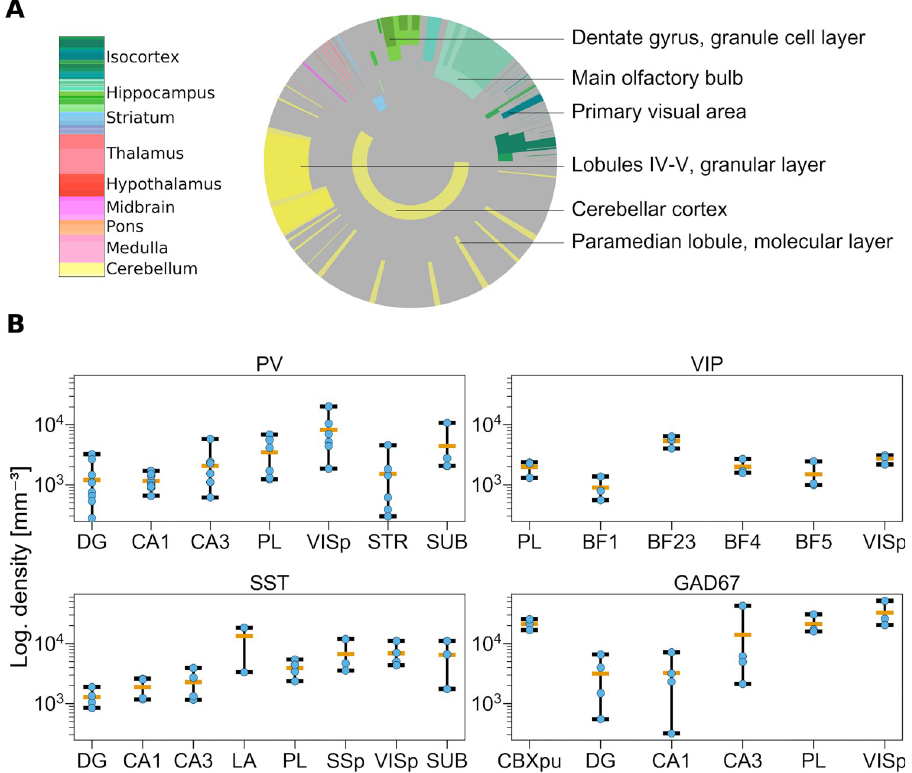
Fig 4. Overview of published data on inhibitory neuron densities in the mouse brain. (A) Illustration of regions for which information on densities or absolute numbers of GAD67+ neurons were published. The disk is divided into rings and sectors. Each ring represents a hierarchical level in the AV and sectors represent the contained regions. The center of the disk represents the entire brain, each surrounding ring then represents the next hierarchy level. Colored areas represent regions where at least one study reports cell numbers or densities. The size of the sectors corresponds to the number of neurons in the region relative to the number of neurons in the brain. The colors correspond to regions according to the AV, such as the cerebellar cortex in yellow and cortical areas in green. (B) Variability of published cell density estimates. Each panel shows the range of reported cell densities (log scale). For each region, data points are depicted in blue, the average in orange. The minimum and maximum values are indicated by the whiskers. Regions shown: Dentate Gyrus (DG); Field CA1 (CA1); Field CA3 (CA3); PreLimbic area (PL); Primary SomatoSensory area (SSp); Primary VISual area (VISp); STRiatum (STR); SUBiculum (SUB); Primary somatosensory area, barrel field (BF); Lateral Amygdalar nucleus (LA); CereBellar corteX, Purkinje layer (CBXpu).